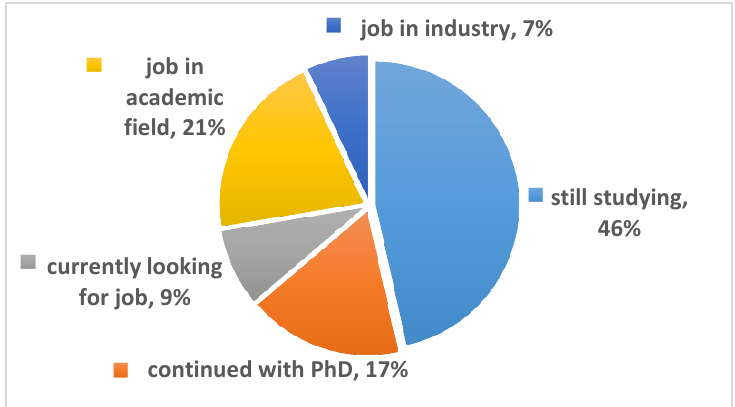
Figure 3. Alumni career activities (FGHT-PG students